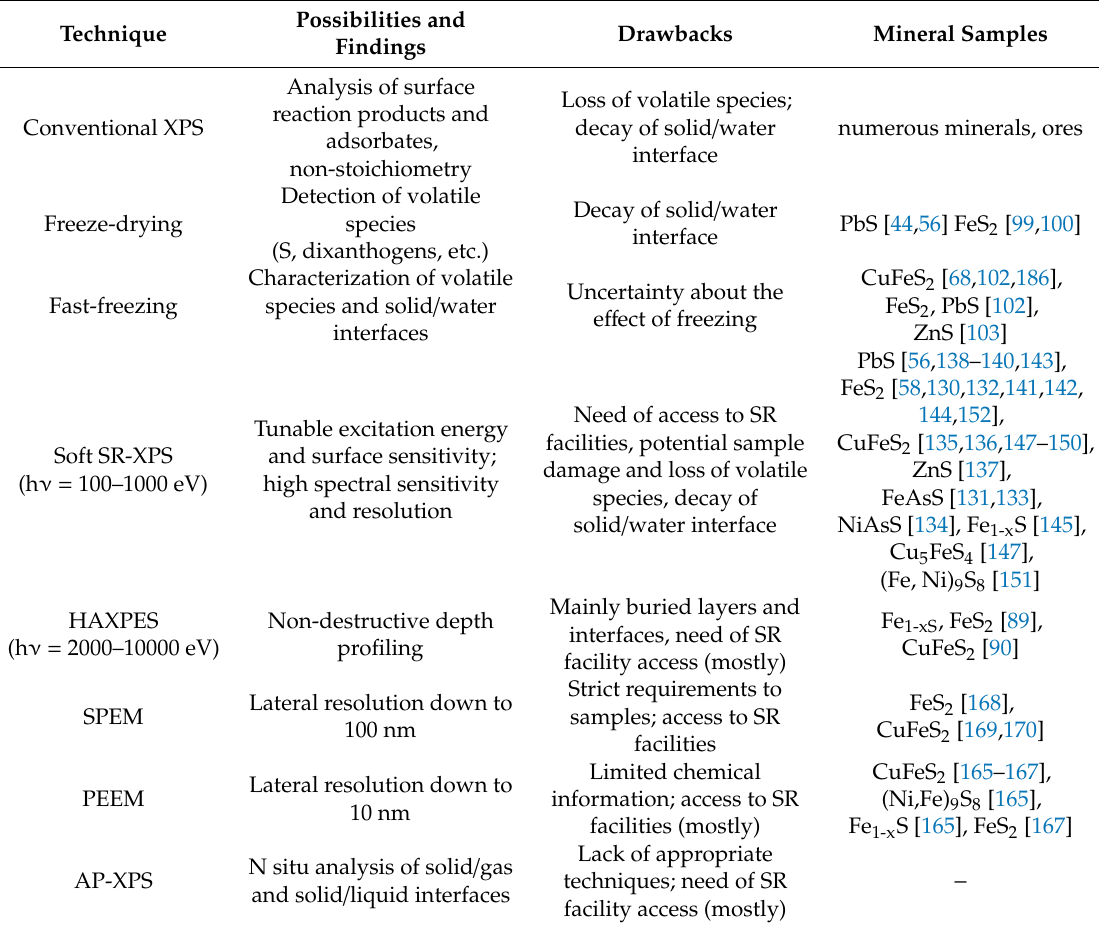
Table 1. Principal possibilities and shortcomings of X-ray photoelectron spectroscopy techniques, and examples of the application to sulfide